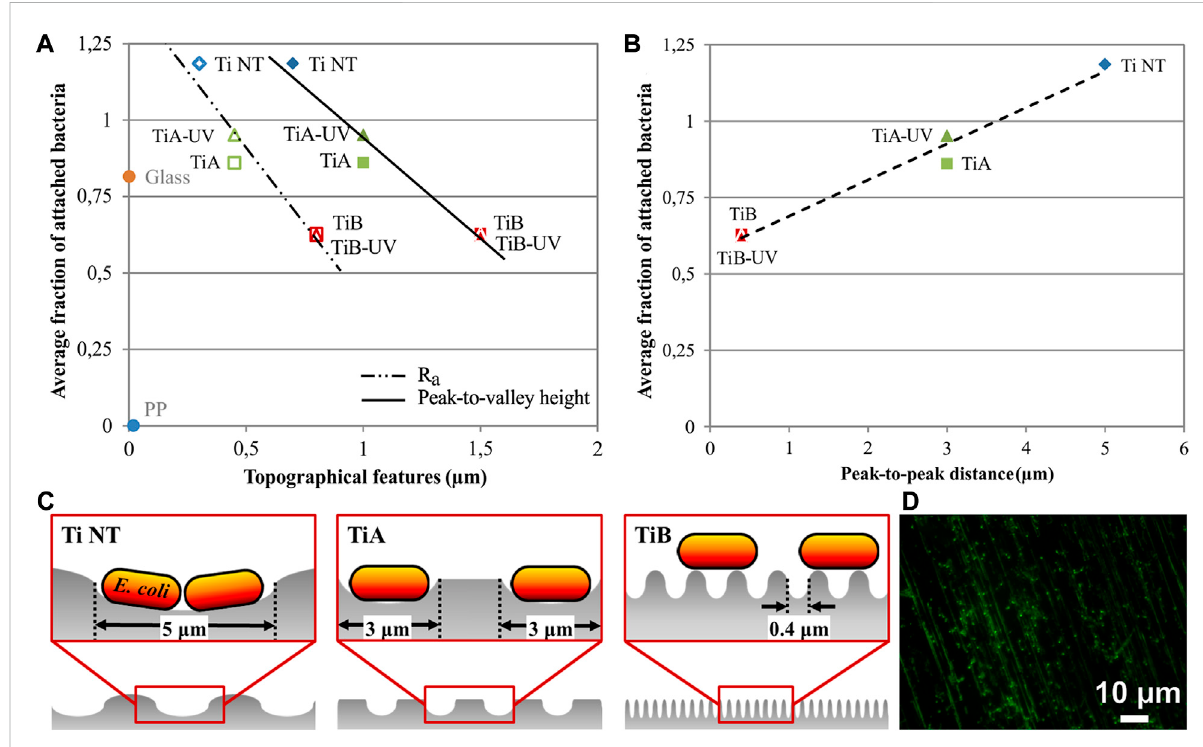
FIGURE 3 Average fraction of adhered bacteria on Ti NT, TiA, TiA-UV, TiB, and TiB-UV samples versus. (A) Peak-to-valley height ( fi lled symbols) and Ra roughness(opensymbols)withinthemachinedgroovesincomparisonwithglassandpolypropylene(PP)surfacesand (B) peak-to-peakdistance. (C) Height versus distance pro fi les for Ti NT, TiA, and TiB samples. (D) Gfp- E. coli stained with Live/Dead kit on Ti NT (Lorenzetti et al.,